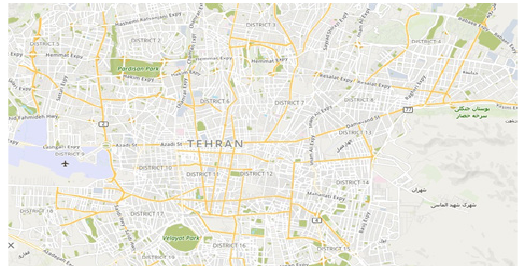
Figure 2: Part of the city's traffic in